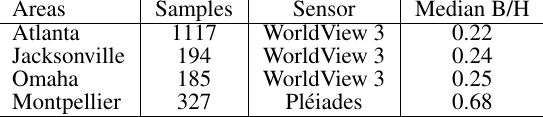
Table 2. List of products used to train the LinkNet INN.